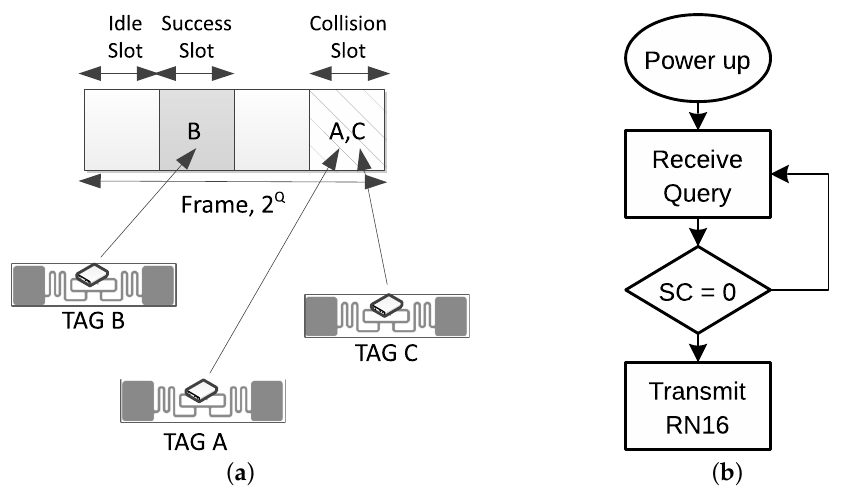
Figure 2. EPC C1G2 definition and slot selection process [8]. ( a ) Slot definitions for EPC C1G2 Identification Phase; ( b ) Tag response procedure to Query command.